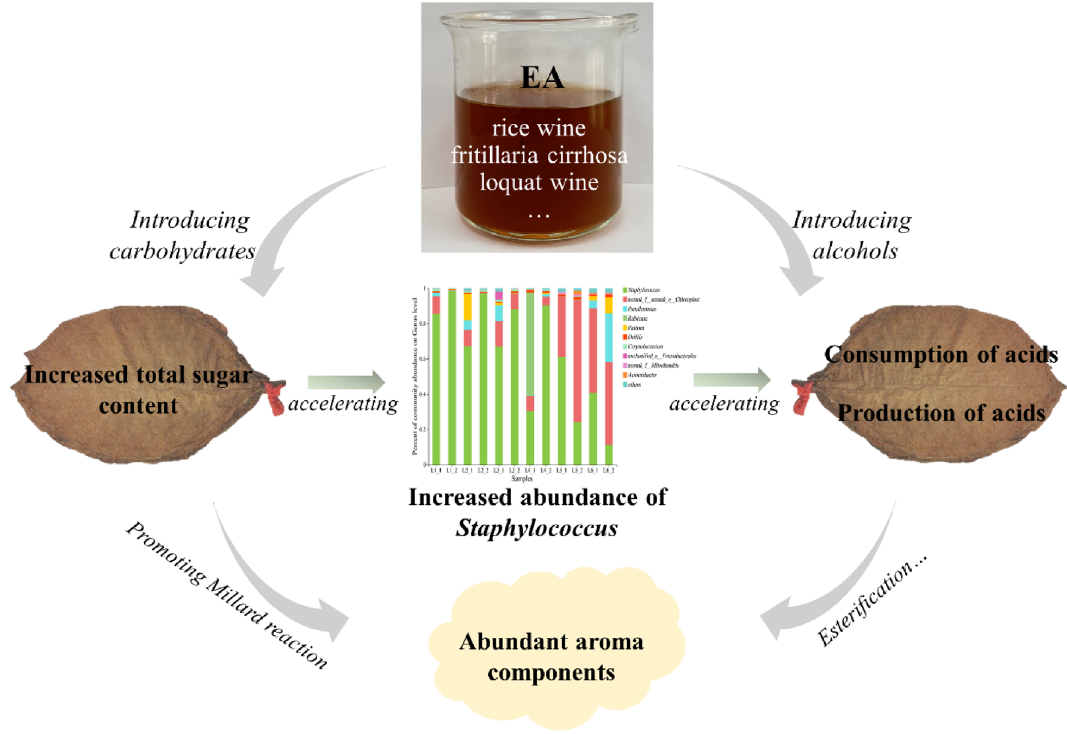
Figure 6. Schematic illustration of mechanism of EA improving the CTLs